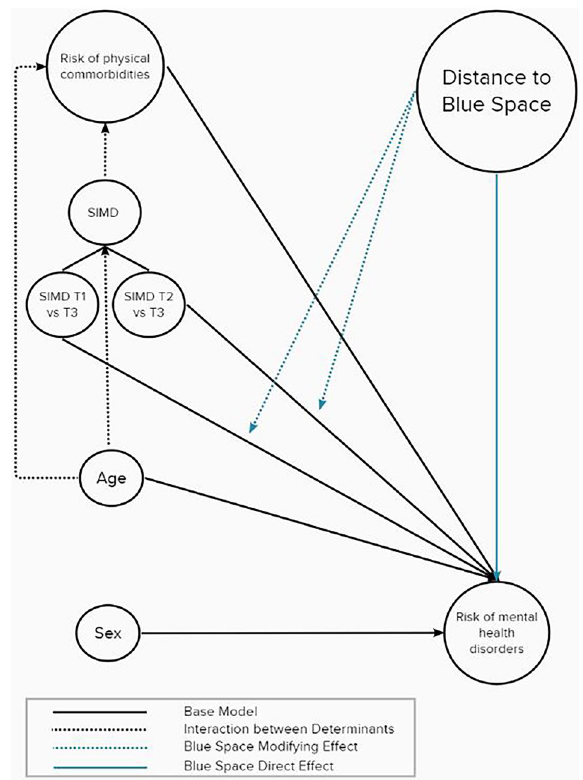
Figure 3. Conceptual directed acyclic graph of the associations between mental health, distance to blue space and mental health determinants/confounders; SIMD T1 (most socio-economically deprived tertile); SIMD T2 (medium socio-economic deprivation